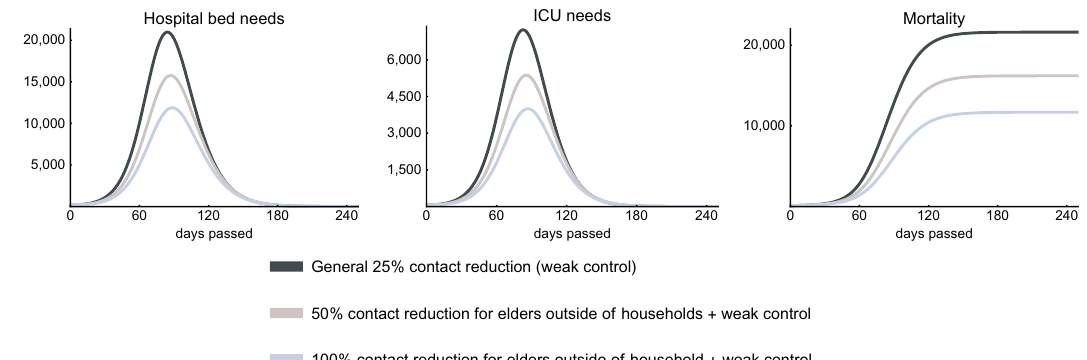
Figure 11. Protection of the elderly. The figures show the effect of an additional contact reduction of elderly people in case of a weak control. The figures suggest that the selective protection of elderly people can successfully reduce the peak ICU need and the overall mortality, yet it has a theoretical